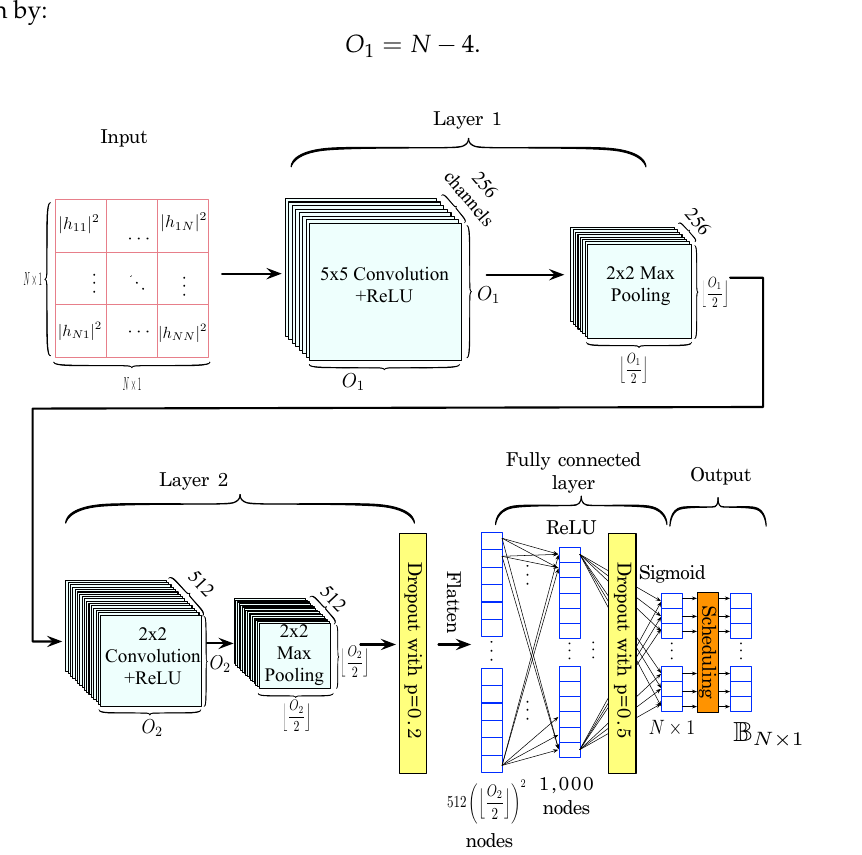
Figure 2. Proposed convolutional neural network for D2D communication